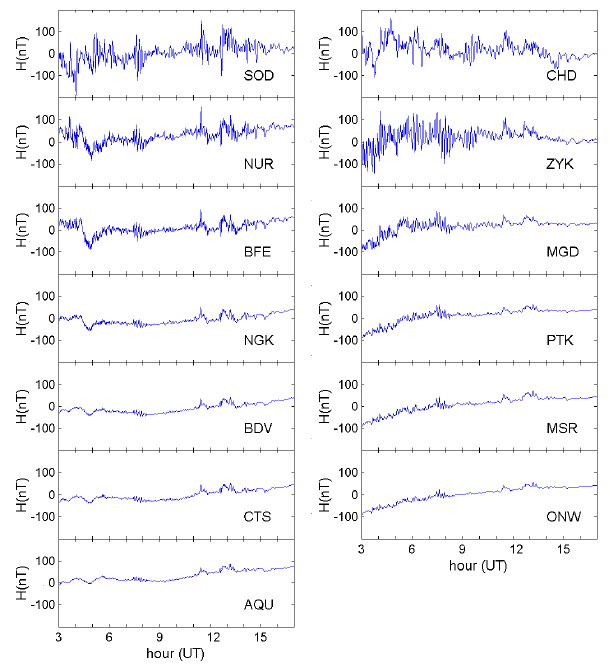
Fig. 2. Variations of the horizontal geomagnetic field H component at the different stations from 03:00UT to 17:00UT on 16 July 2000. Left and right panels correspond to the European and the Asiatic array,